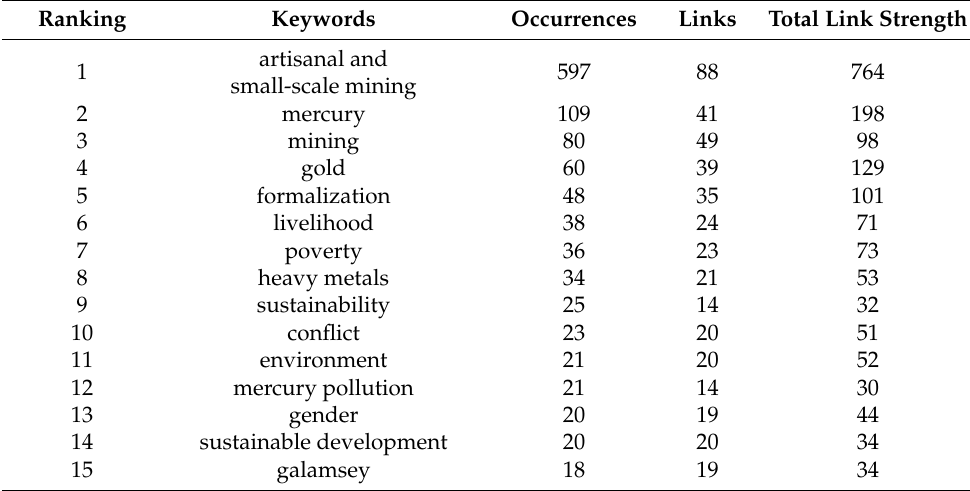
Table 4. The 15 main words with the highest occurrence in ASM